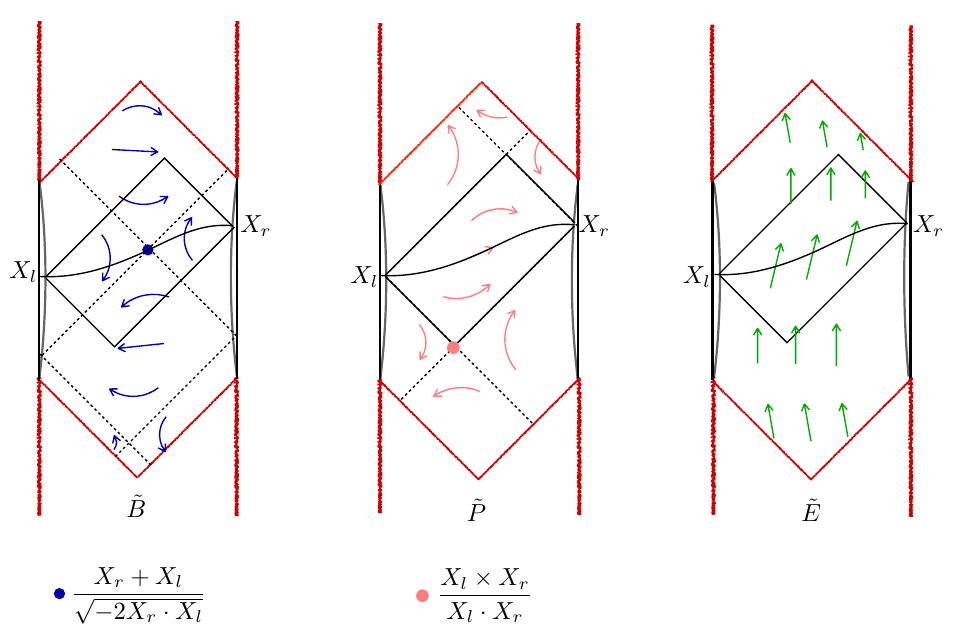
Figure 2 . Geometrical action of the gauge invariant charges ˜ P, ˜ B, ˜ E . The points which are fixed by the symmetry generators are also